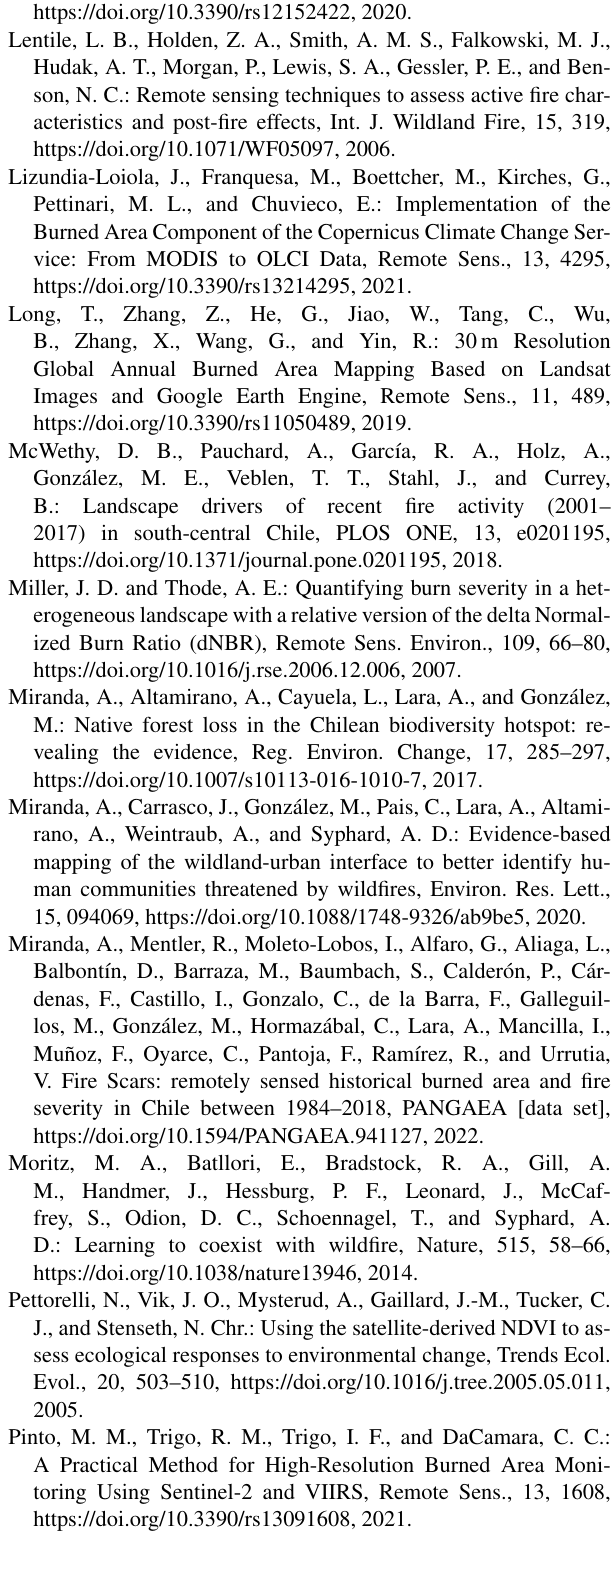
Key, C. H. and Benson, N. C.: The normalized burn ratio (NBR):